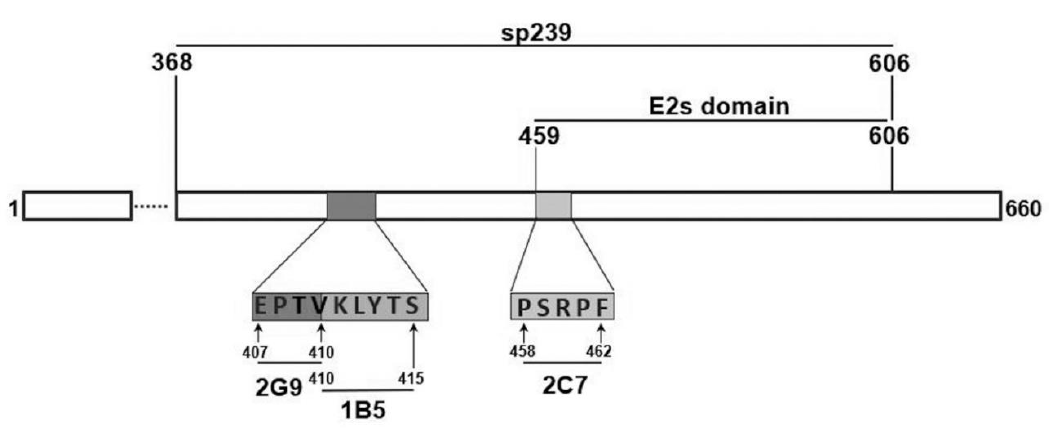
Figure 1. Schematic diagram showing linear positions of sp239, E2s domain, and genotype 4 swine hepatitis E virus (HEV) capsid protein-neutralizing epitopes recognized by monoclonal antibody (Mab) 2G9, 1B5, and 2C7.